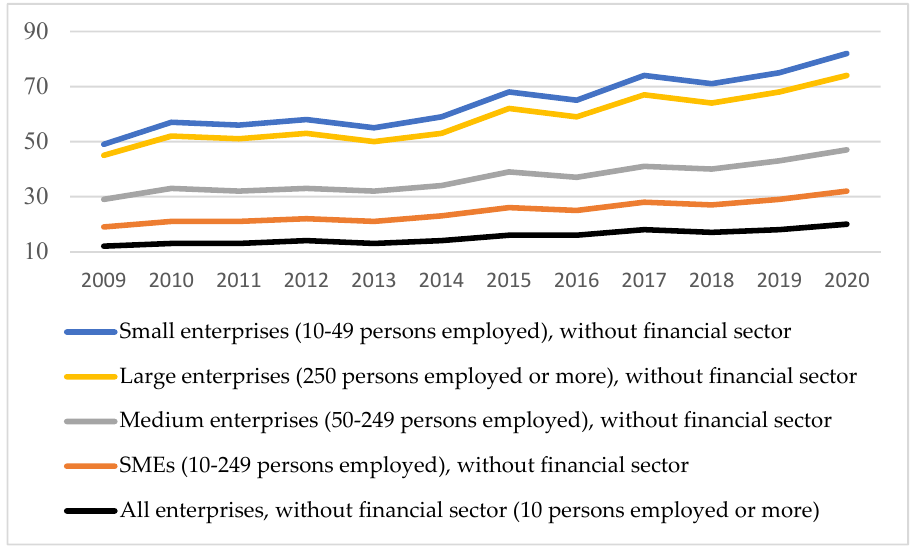
Figure 10. Share of enterprises’ turnover on e-commerce. Source: Authors projection using EURO- STAT database, Digital economy and society (t_isoc_i) Data extracted on 12 September 2021, online data code: TIN00110.